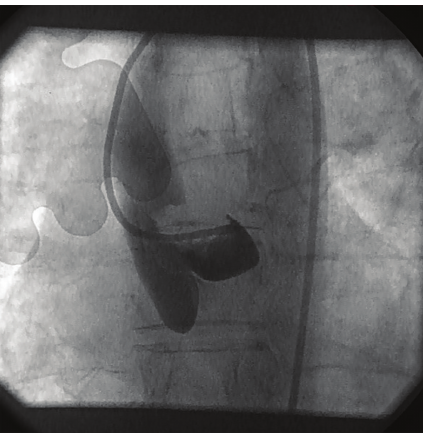
Figure 1: Initial aortogram showing aortic root mass.